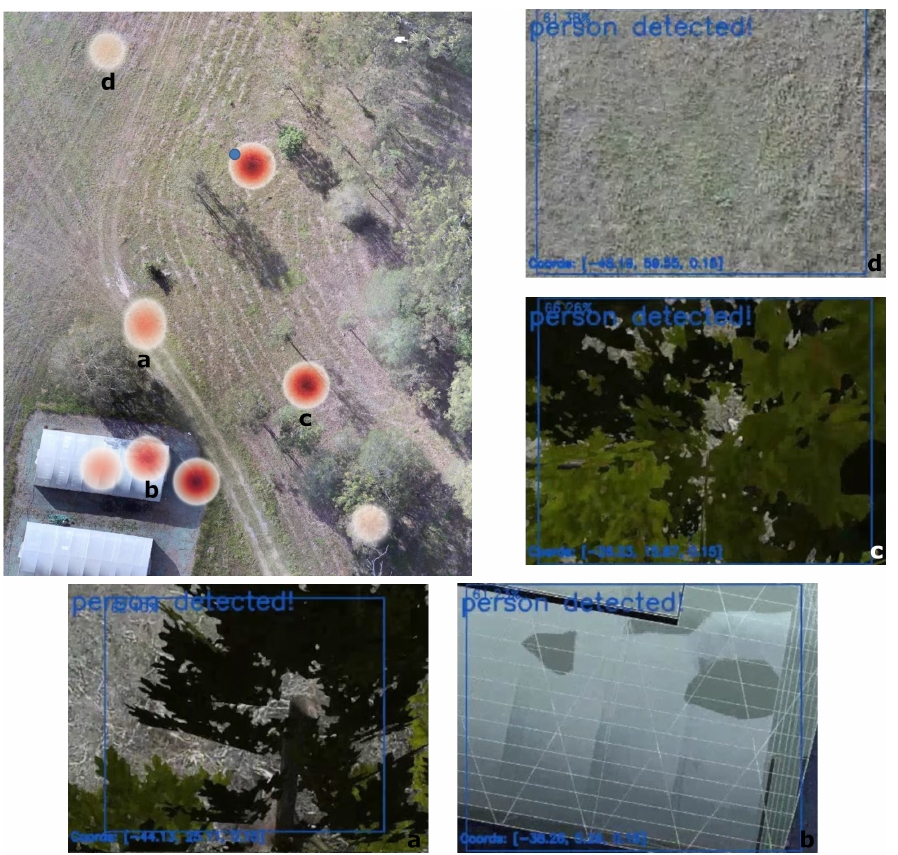
Figure 16. Most common object visualisations that triggered false positive readings of people in mission mode. Other objects wrongly detected as people included trees, greenhouse rooftops, and to a lesser degree, bare grass.